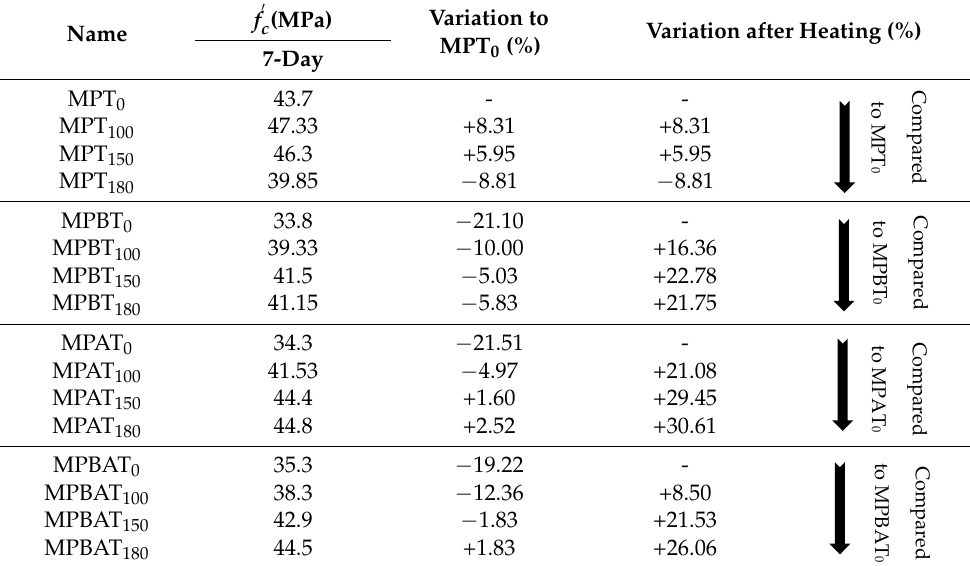
Table 7. Compressive strength for the PC with/without SA and BF.